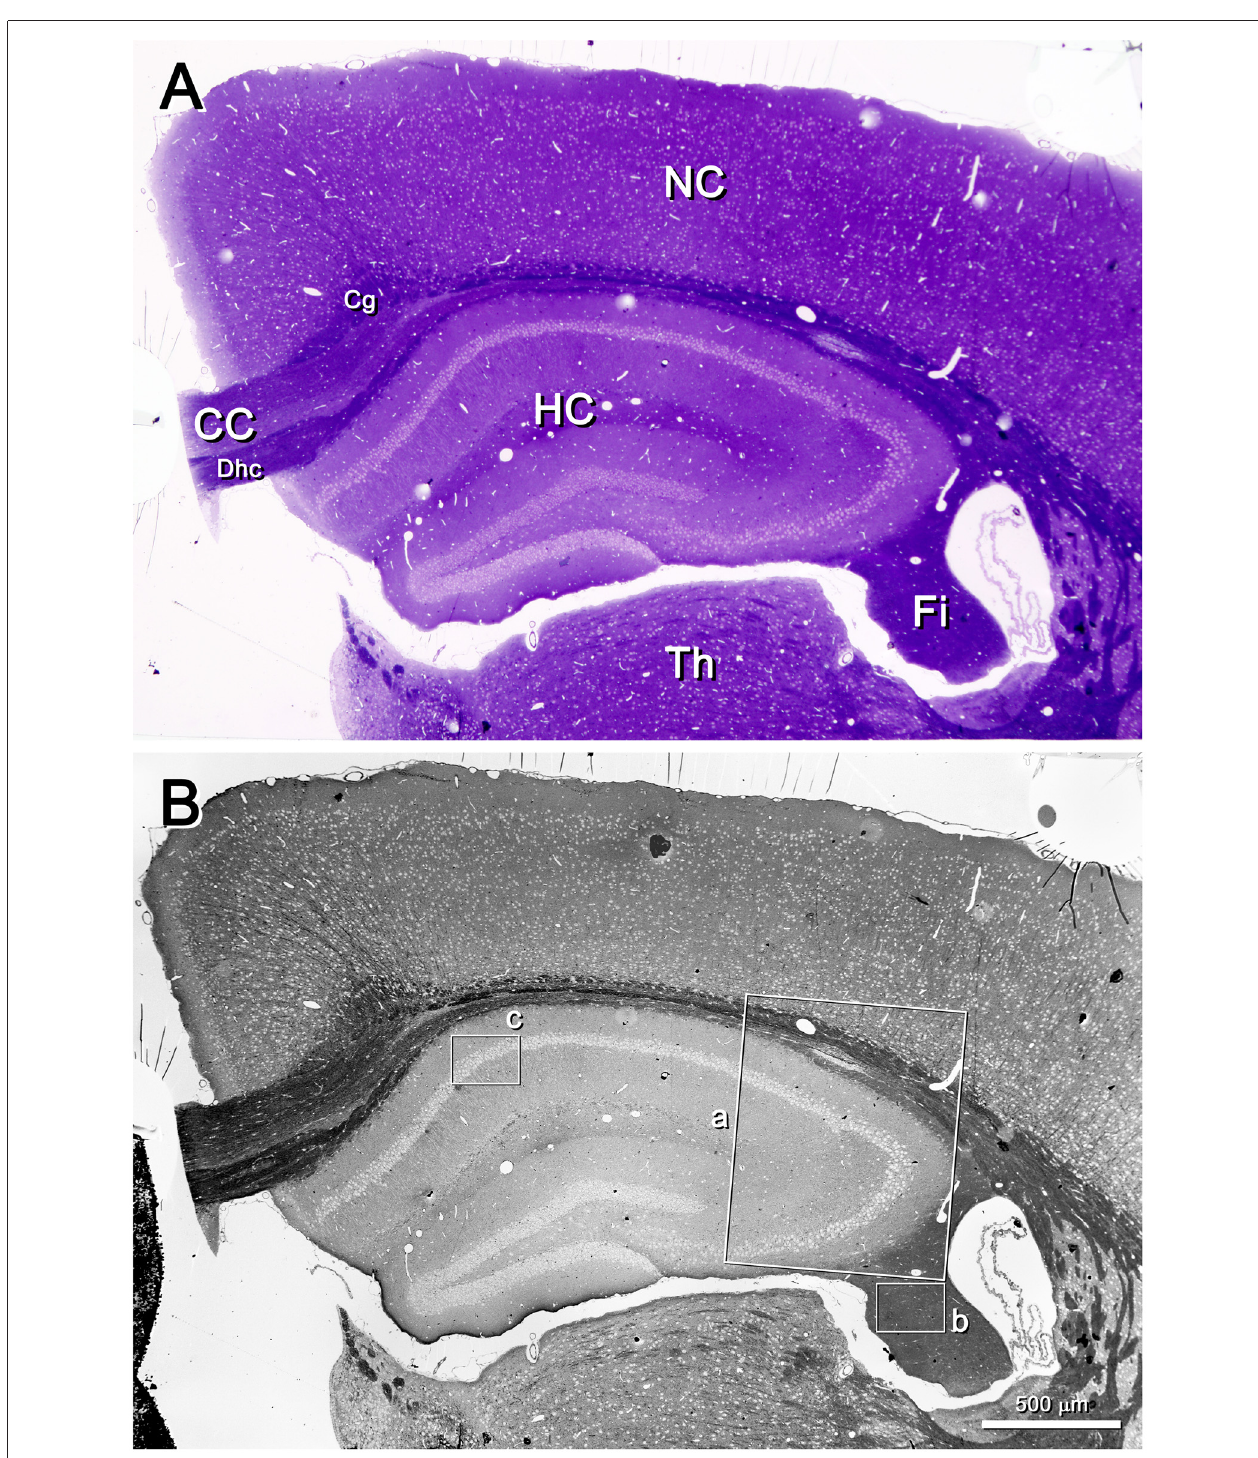
FIGURE 2 | Semithin section of the mouse brain. (A) Toluidine blue-stained semithin section (0.5 µ m thick) photographed with a light microscope. The resolution is good enough to identify gross structures such as the hippocampus (HC), the neocortex (NC) and thalamus (Th). White matter subdivisions are also visible, such as the corpus callosum (CC), dorsal hippocampal commissure (Dhc), cingulum (Cg) and fimbria (Fi). (B) The same semithin section imaged with a SEM. The SE2 detector has been used, with an acceleration voltage of 8.00 kV. The lighter profiles correspond to cell somata, while the darkest structures correspond to white matter. Original magnification was 30 × , equivalent to a resolution of 1.86 µ m/pixel. The original field of view was 3.811 × 2.858 mm; the frame was later slightly cropped horizontally. The insets a, b and c have been further imaged in Figures 3 , 4 , 6 , respectively.